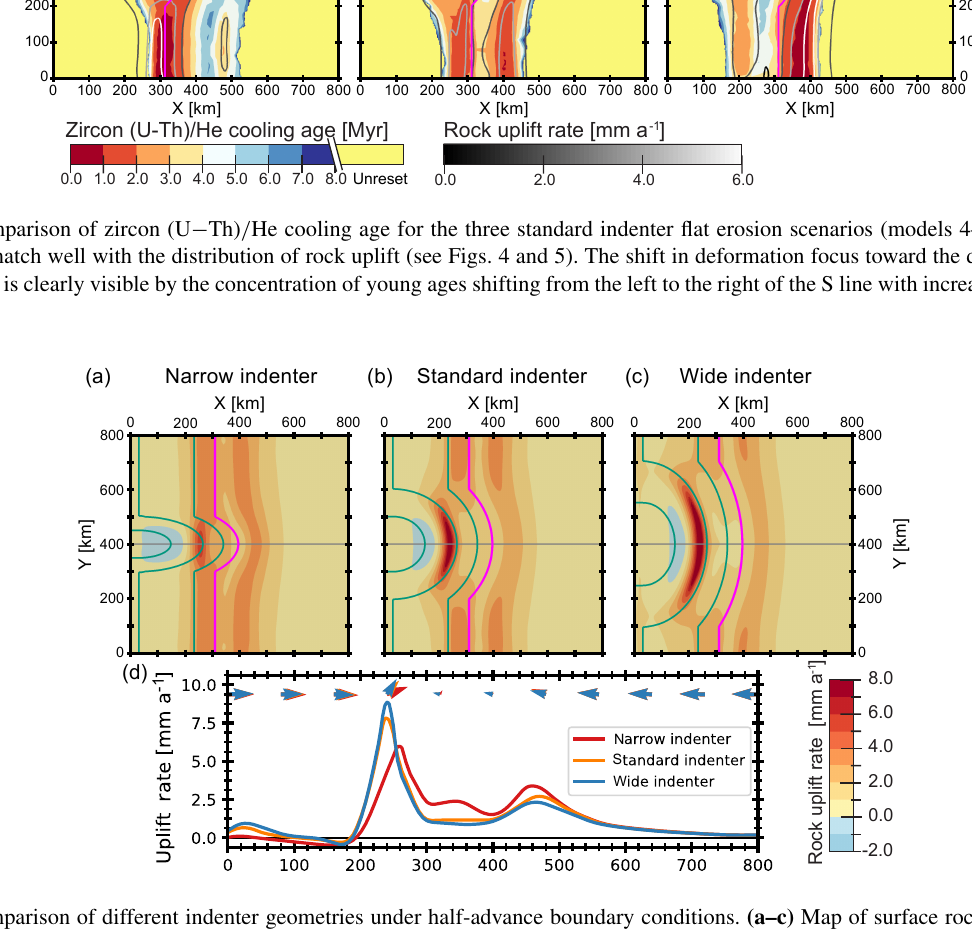
Figure 7. Comparison of different indenter geometries under half-advance boundary conditions. (a–c) Map of surface rock uplift rates for narrow, standard, and wide indenter geometry. (d) Rock uplift rates along a central cross section (gray line in a – c ). Basic distribution of uplift is similar in all models with a region of increased uplift above the indenter apex at x ≈ 225km, y ≈ 400km. Maximum rock uplift rates increase with indenter